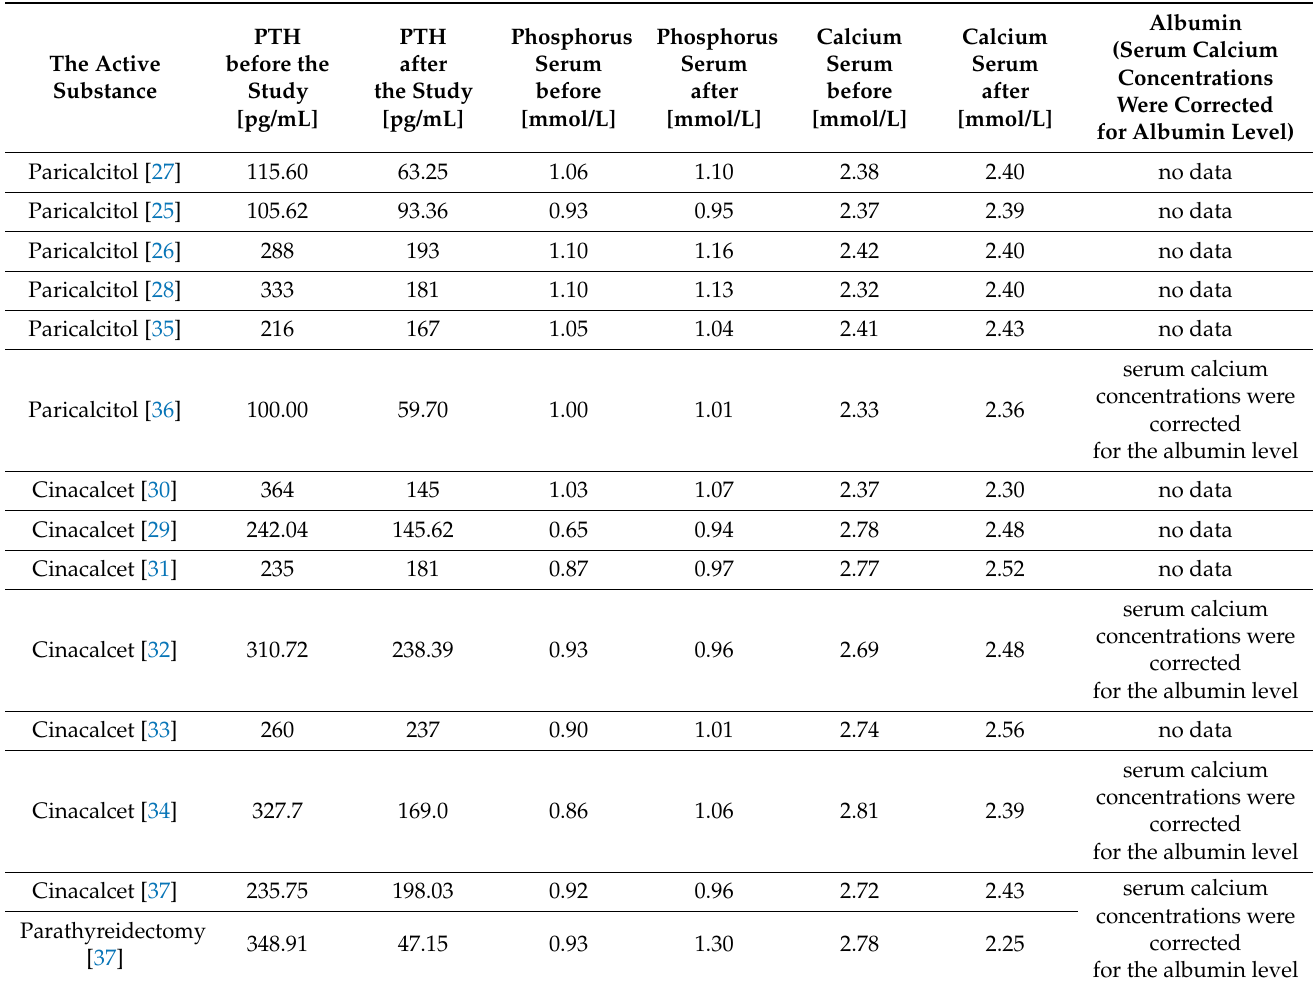
Table 2. Changes in the serum concentration of PTH, calcium, phosphorus, and the value of albumin, or information regarding the corrected serum calcium concentration based on the albumin level